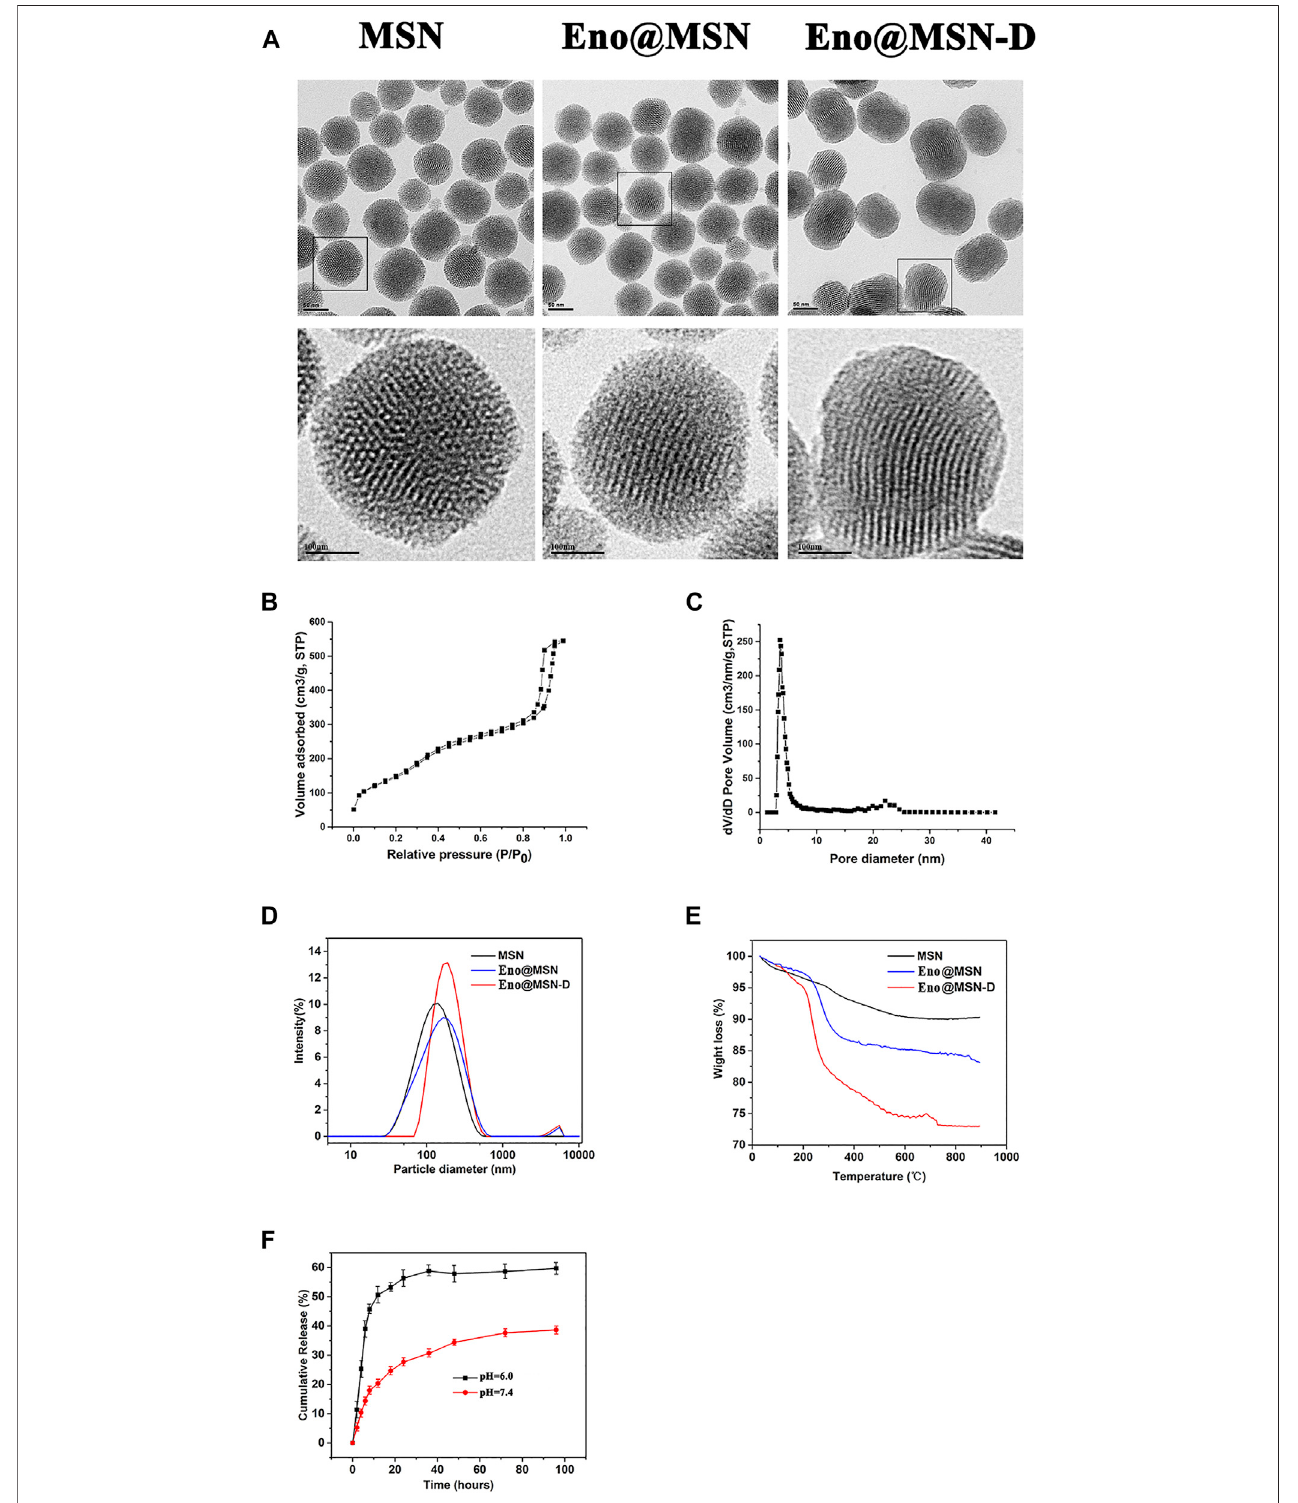
FIGURE2|(A) TypicalTEMimagesofMSN,Eno@MSN, andEno@MSN-D. (B) .N 2 adsorption − desorptionisothermscurves oftheMSN. (C) Poresizedistribution curves of the MSN. (D) The dynamic light scattering (DLS) curves of MSN, Eno@MSN, and Eno@MSN-D. (E) TGA curves recorded for MSN, Eno@MSN, and Eno@ MSN-D. (F) Accumulative release curve of Eno@MSN-D in different pH PBS ( p H (cid:1) 7.4, 6.0).